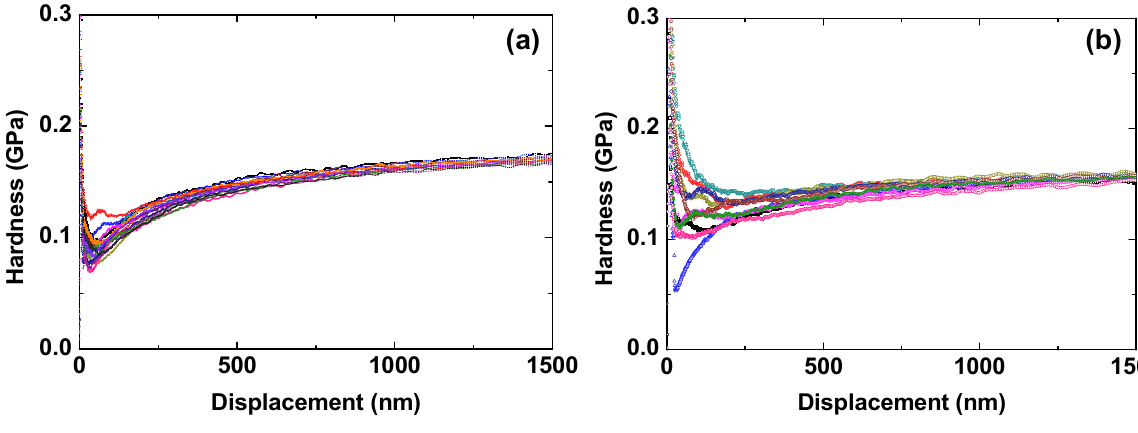
Figure 5. Hardness of ( a ) PI and ( b ) PET substrates. Tests were conducted for 16 positions on samples.